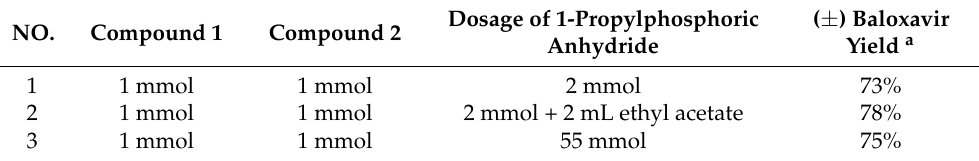
Table 3. Screening of dosage of 1-propylphosphoric anhydride.